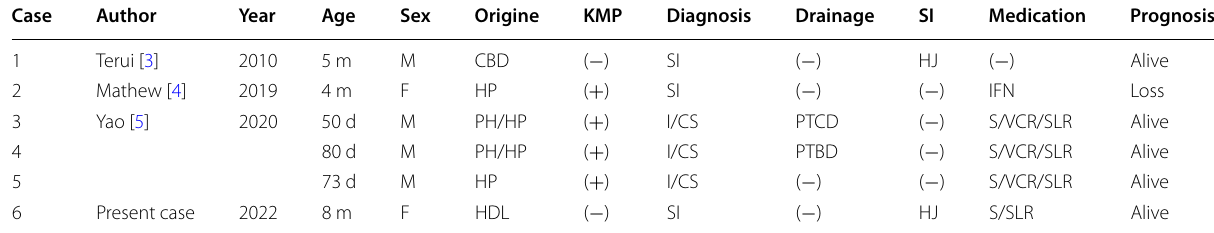
CBD common bile duct, CS clinical symptoms, HDL hepatoduodenal ligament, HJ hepaticojejunostomy, HP head of the pancreas, I images, IFN interferon, KHE Kaposiform hemangioendothelioma, KMP Kasabach–Merritt phenomenon, PH porta hepatis, PTBD percutaneous transhepatic biliary drainage, PTCD percutaneous transhepatic cholangiodrainage, SI surgical intervention, SLR sirolimus, VCR